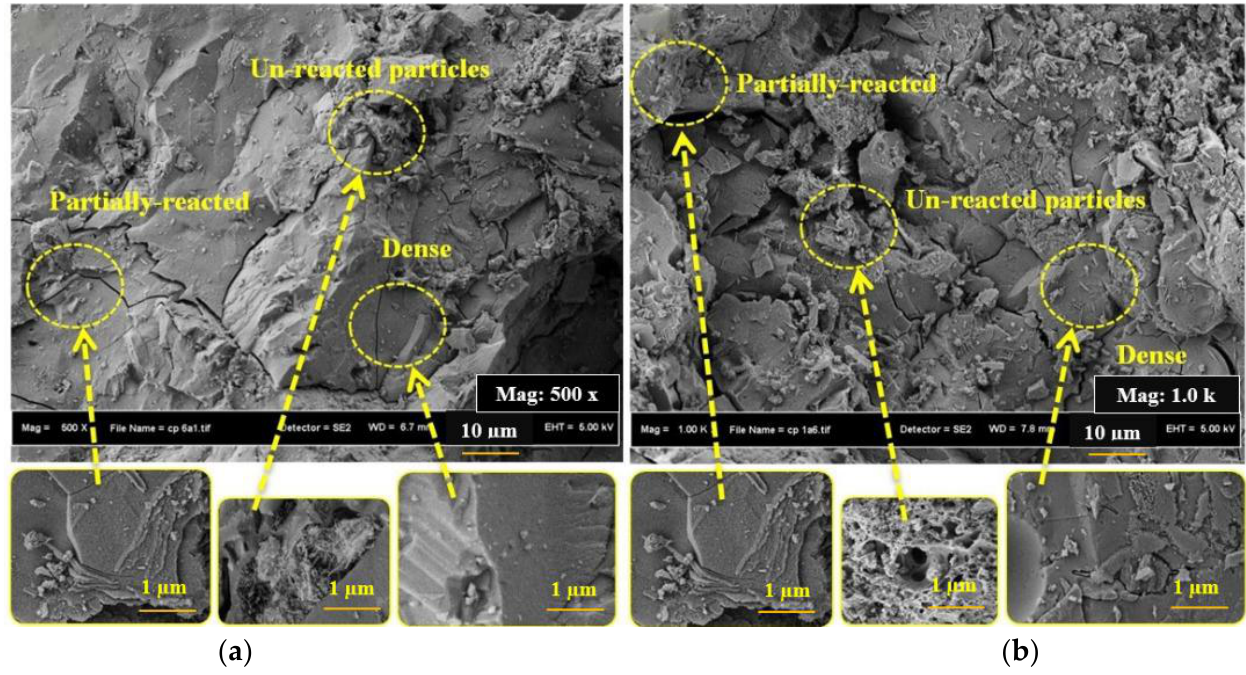
Figure 6. Surface morphology of SCAACs containing CWP at ( a ) 45% and ( b ) 80%.